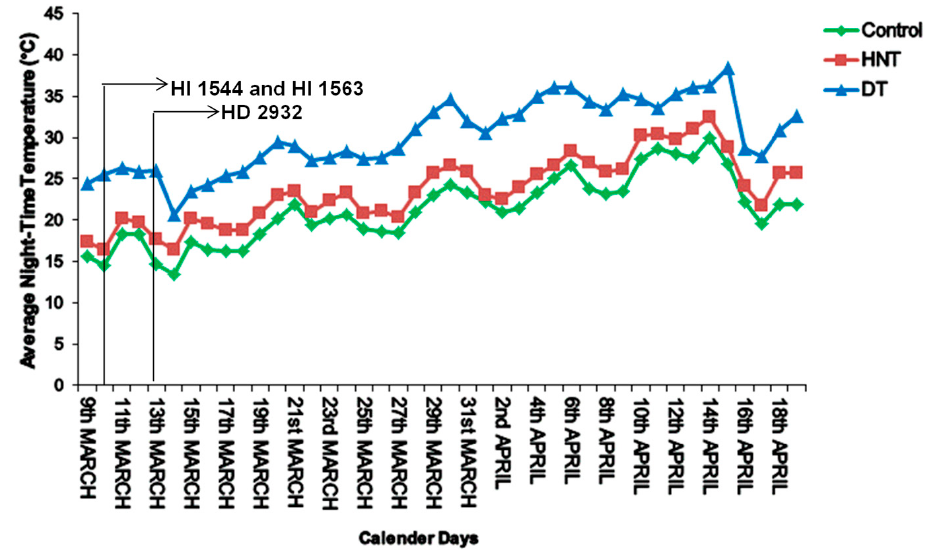
Figure 1. Average nighttime (18:00 to 06:00 h) temperatures in control and HNT chambers during the grain growth period of all the genotypes. DT represents daytime temperature during the same period. The arrows on the X -axis represent the time of anthesis.